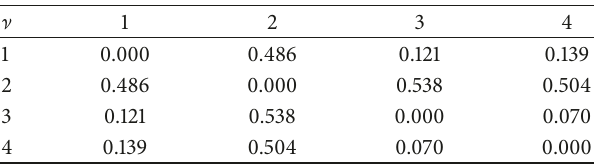
Table 7: Nonmembership parts of the intuitionistic fuzzy pairs, giving the intercriteria correlations between measurements of iris